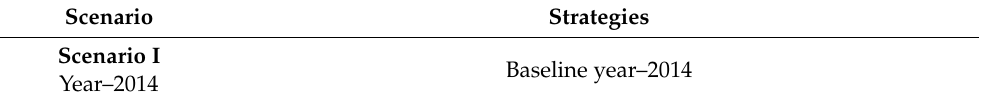
Table 1. The control strategies of the different